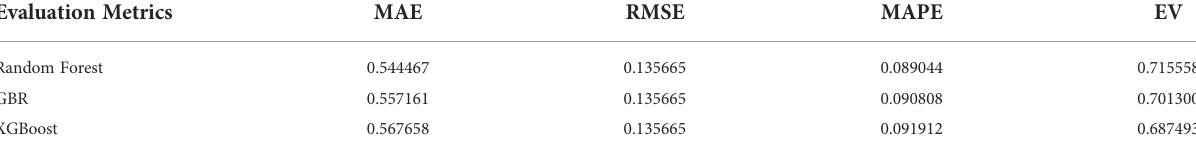
TABLE 4 Model test error analysis.